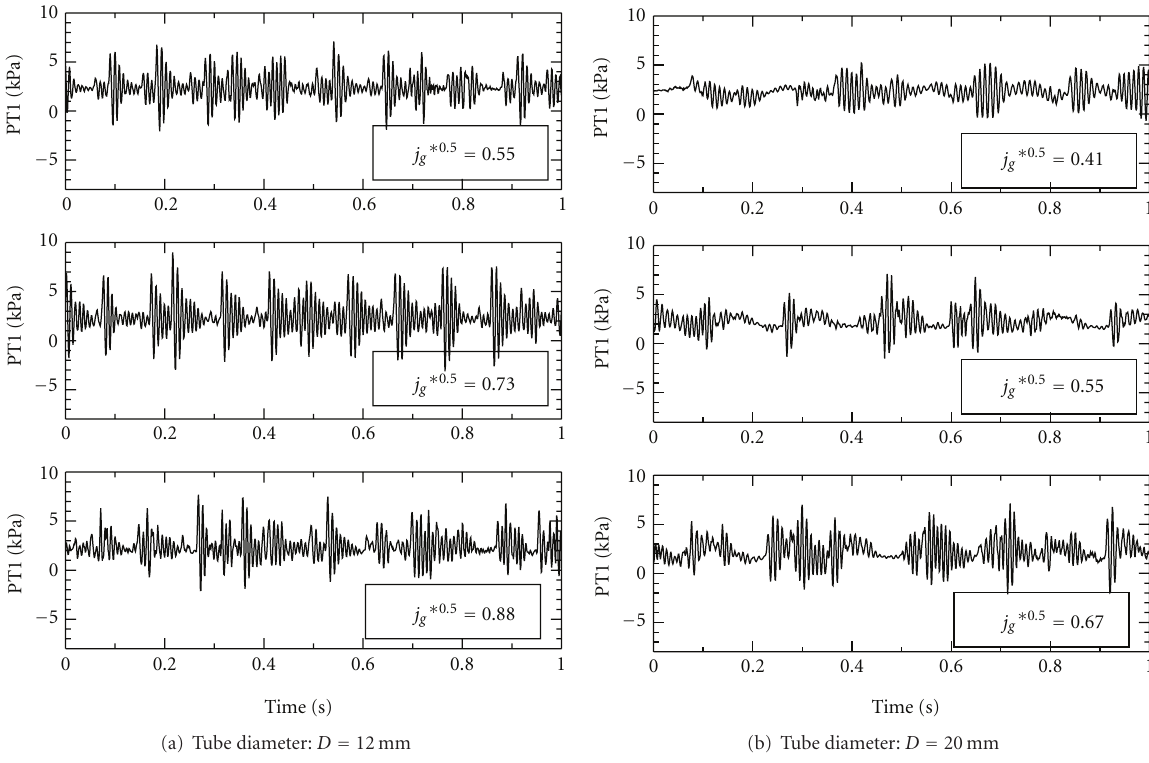
Figure 8: Typical time traces of pressure at the upper entry of the tube